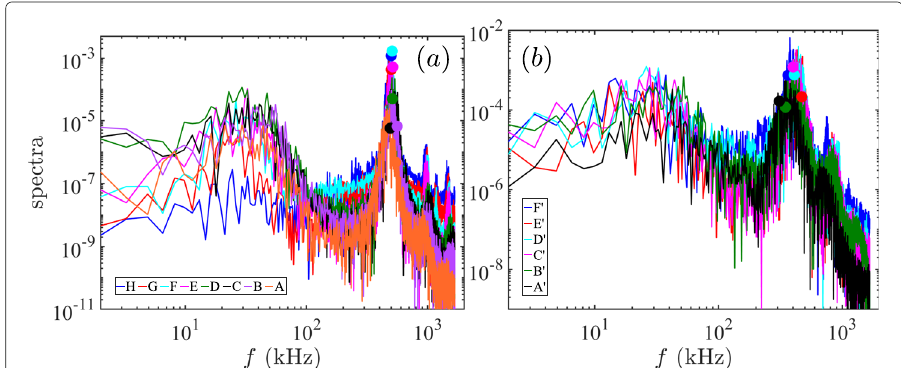
Fig. 6 The temporal spectra of p w at probe points in the Group 1 a and Group 2 b . Symbols denote the estimation f = ¯ q e / 2 δ